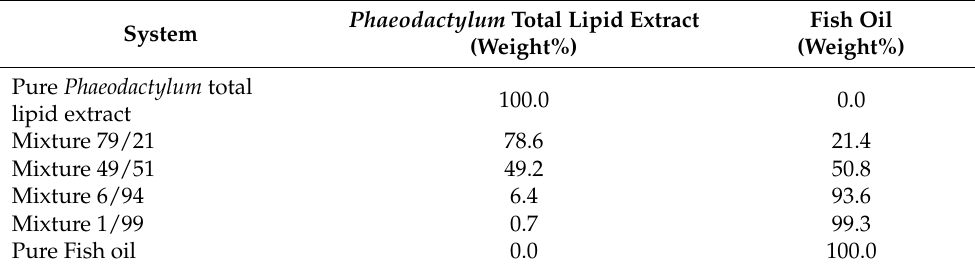
Table 1. Ratios (in weight%) of the Phaeodactylum total lipid extract and fish oil used for preparing the different systems of Part II of the experimental